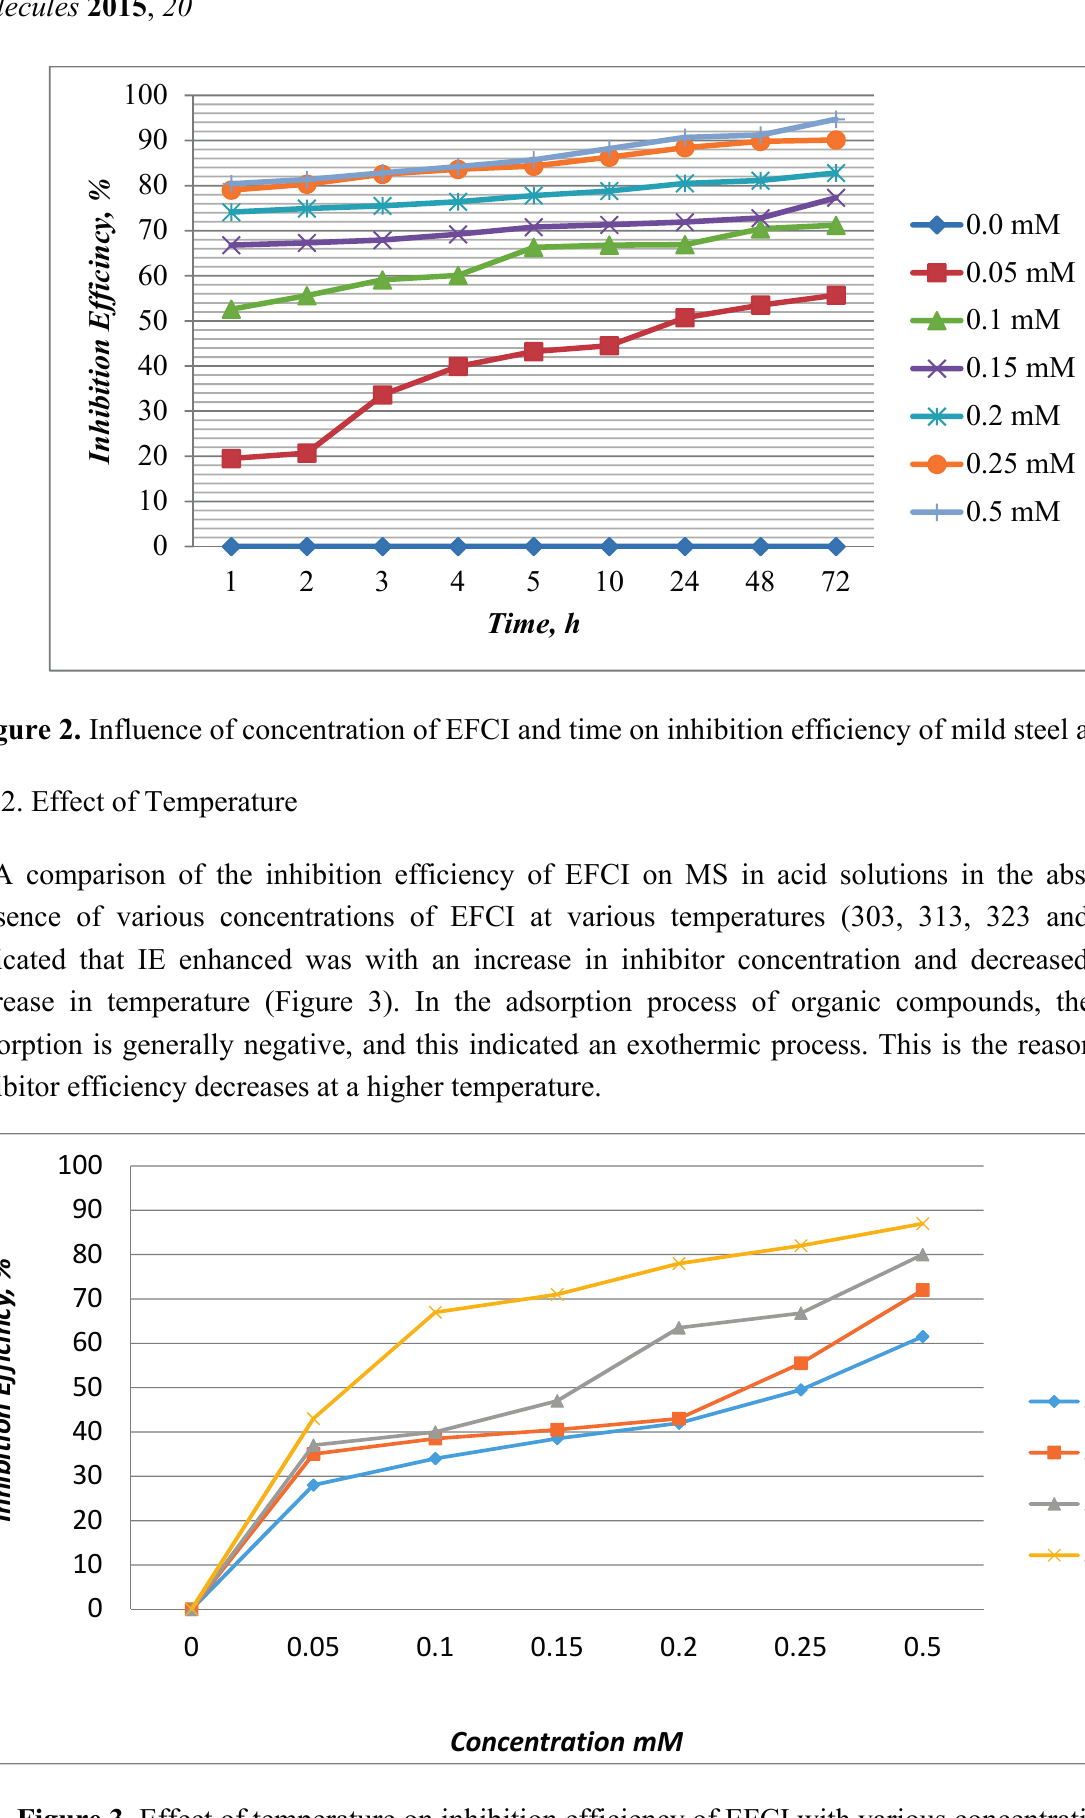
Figure 3. Effect of temperature on inhibition efficiency of EFCI with various